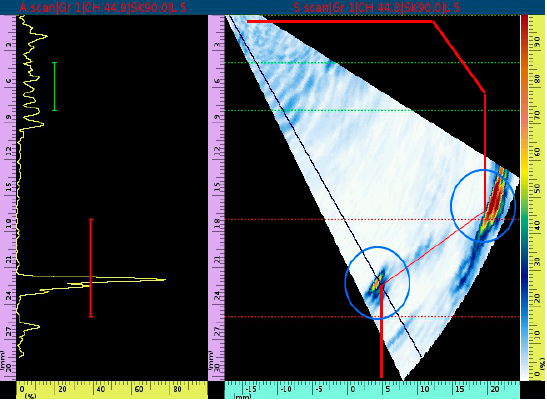
Figure 14. Echo analysis of the structure signal in the defect-free position of the test specimen. Circumferential scanning is used to detect defects. Figure 15a,b show the detection images of crack defects 1# and 2#, respectively. The A-scanning image is on the left, the fan-scanning image is on the right, and the C-scanning image is on the bottom. The signal echo of the internal crack defect and the signal echo of the workpiece structure can be clearly distinguished from the fan-scanning image. It can be seen from the simulation analysis that the signal echo of the crack defect is weak. In the actual detection process, it is necessary to adjust the input to identify the signal echo of the defect, which leads to many other signals, removing the signal echo of the defect and structure. These other signal echoes are the back wave of the detection contact surface and the secondary echo of the structure, which can also be clearly distinguished and excluded during the detection process. At the same time, the horizontal distance and vertical depth of the crack defect are 10.5 mm and 8.1 mm, respectively, which are basically consistent with the actual position of the defect inside the workpiece. In addition, it can also be seen in the C-scanning image that the signal echo of crack 2# is stronger than that of crack 1#, which is basically consistent with the simulation analysis result.